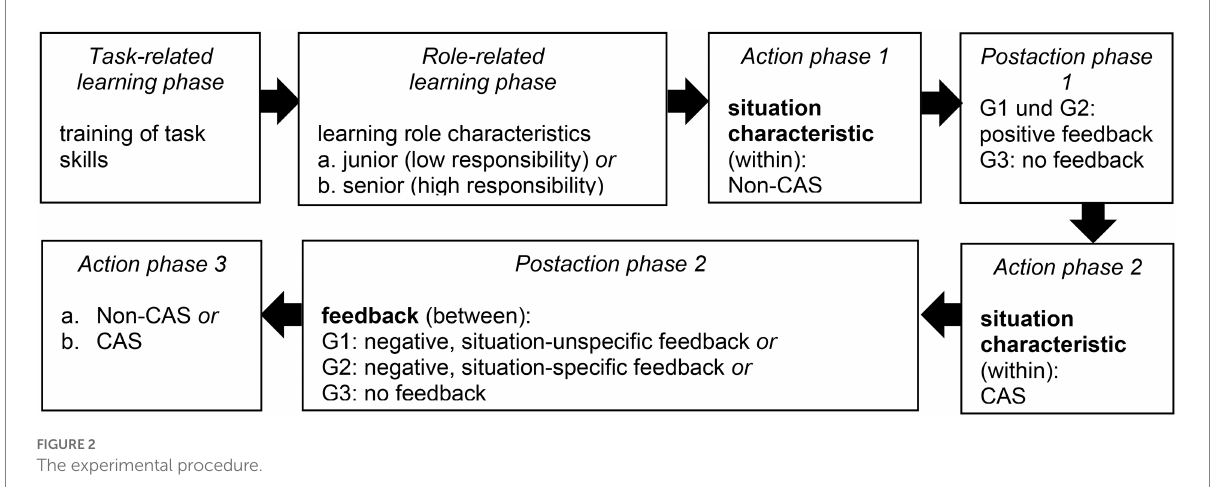
FIGURE 2 The experimental